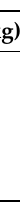
Table 1. Average birds weight, measured in kg. The birds are weighted once per week, and the given value is the result of the average for several birds. Information collected from the farm management